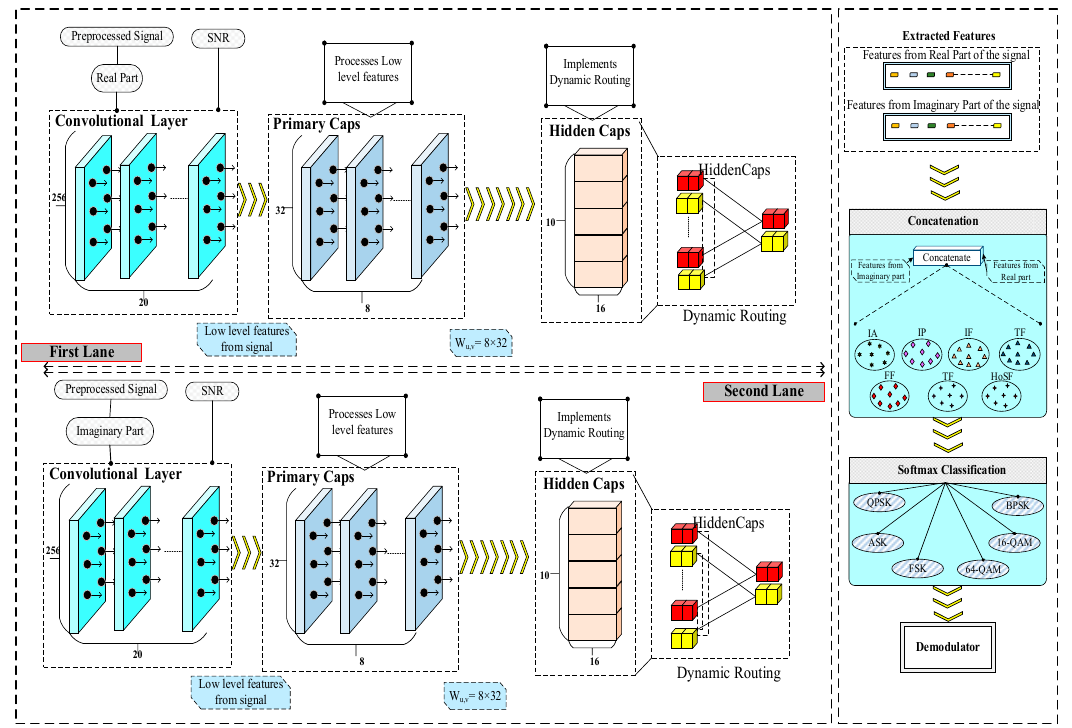
Figure 5. Proposed two-layer capsule network (TL-CapsNet) model.